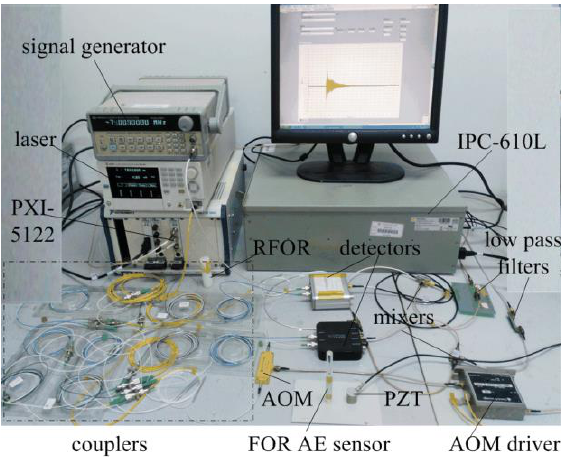
Figure 7. FOR AE system setup.